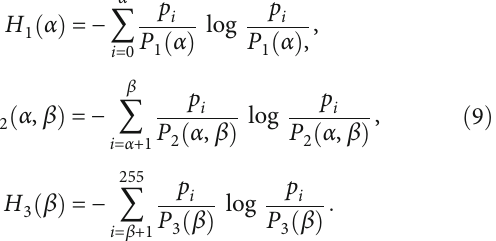
Figure 7: Feature points of semicrater